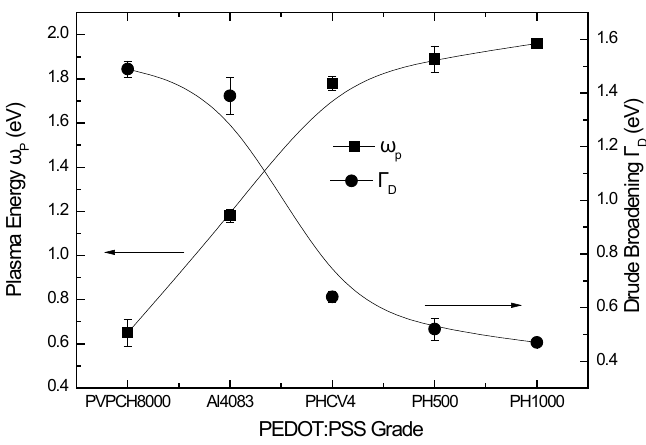
Figure 5. Calculated plasma energy ( ω p ), and Drude broadening ( Γ D ) values of the different PEDOT:PSS formulations.